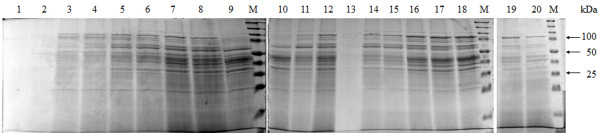
SDS PAGE of disrupted samples derived from various stages of homogenizer. Lane 1–20 represents the experimental runs as depicted in Table 1 and lane M represents broad range protein marker.